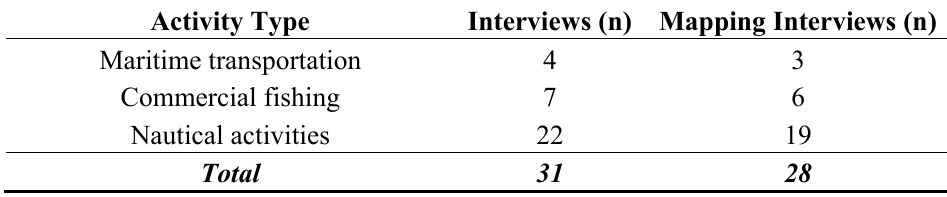
Table 2. Semi-structured interviews carried out to collect data per activity